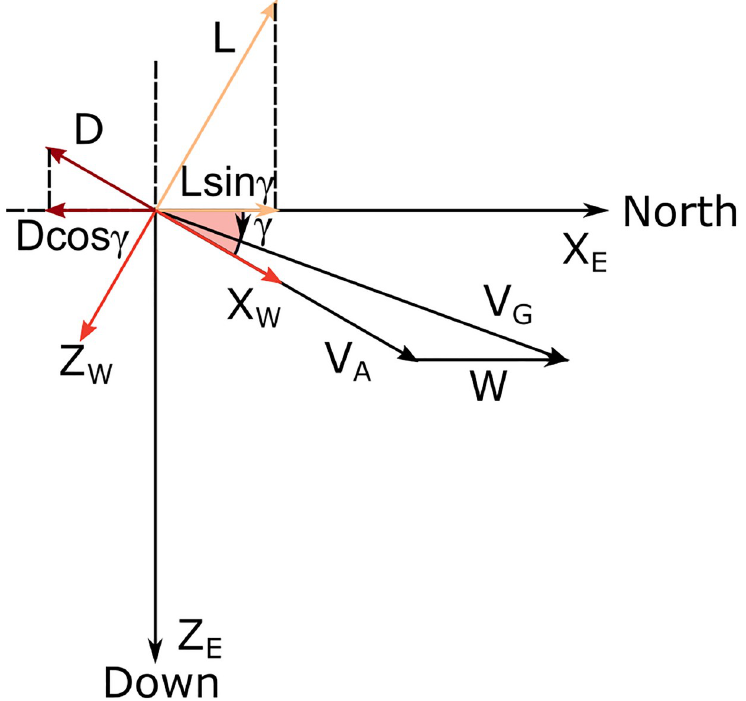
Fig 6. Sketch for the descent phase. Velocity vectors and forces during the descent phase with no bank ( ϕ = 0) and heading north ( ψ = 0).